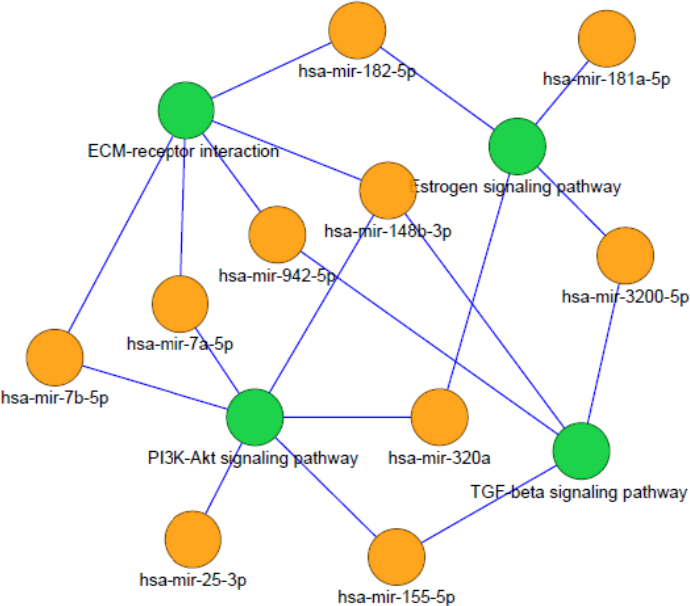
Figure 1. miRNA pathway interactions of most significant pathways.